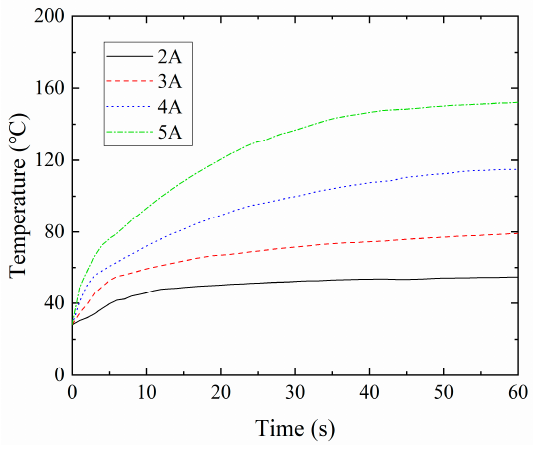
Figure 3. Temperature variation of NiTi SMA wire subjected to different currents. Table 3. The phase transformation spending time to reach A f using different